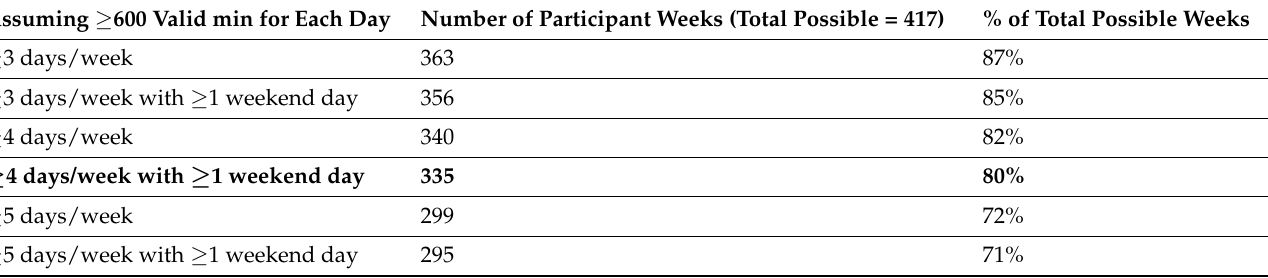
Table 6. Data inclusion based on weekly wear for the entire sample.